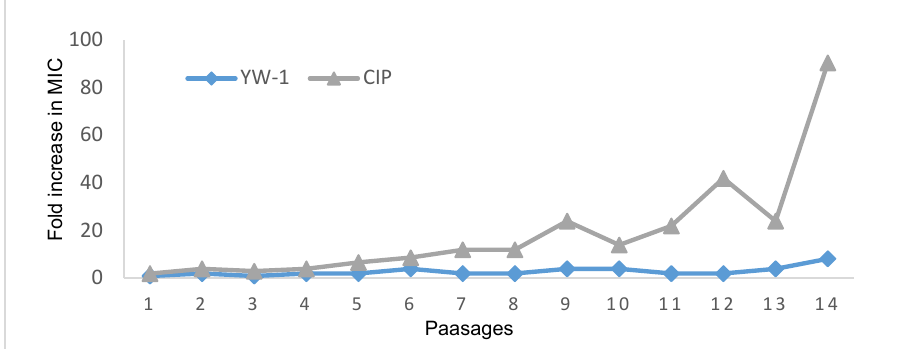
Figure 7. Drug resistance study of YW-1 toward